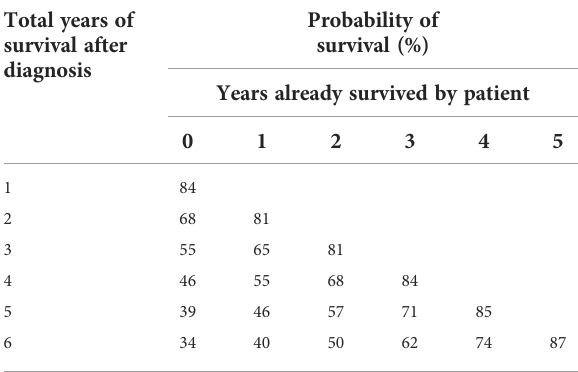
TABLE 2 Conditional cause-speci fi c survival estimates. Total years of survival after